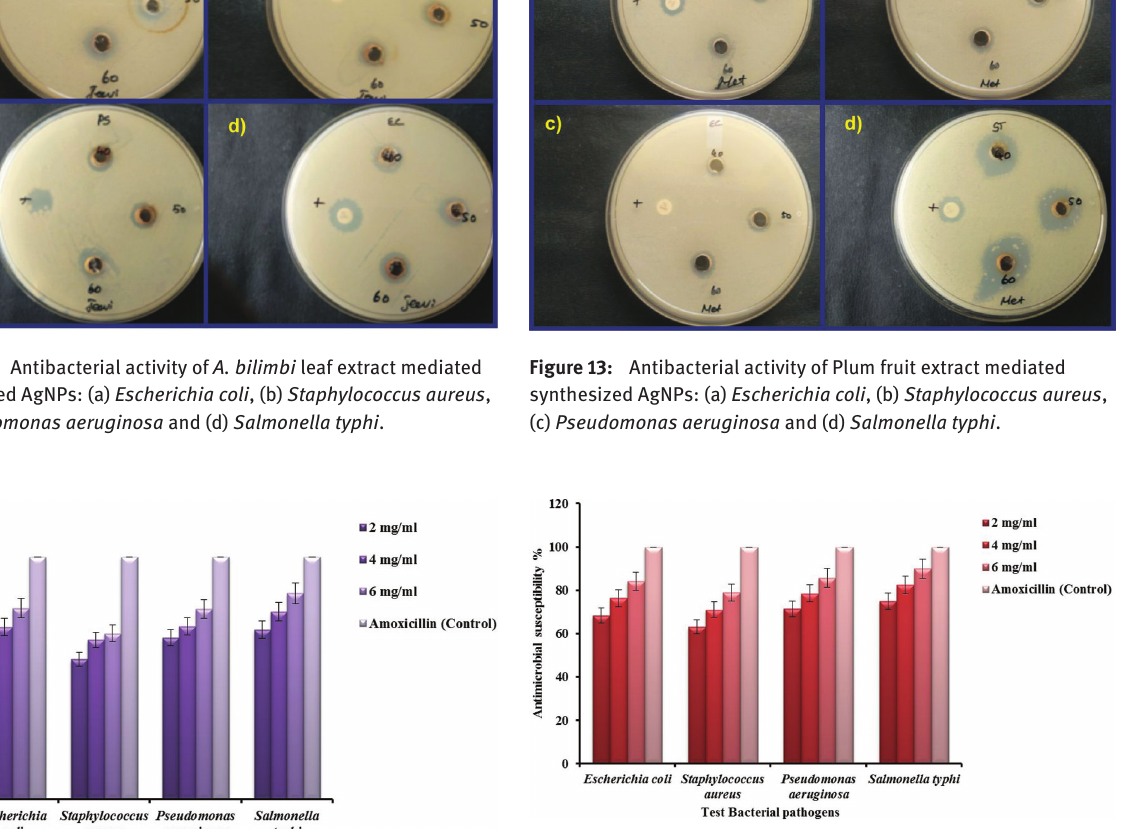
Figure 14: Antimicrobial susceptibility of Ag NPs synthesized by Plum fruit extract represented in